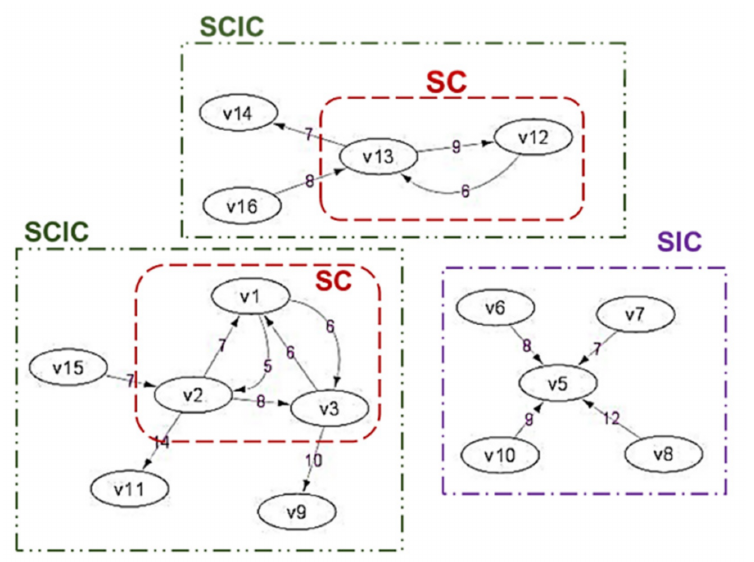
Figure 6. Illustration of active communities formed from a weighted-directed graph with threshold of edge weight =